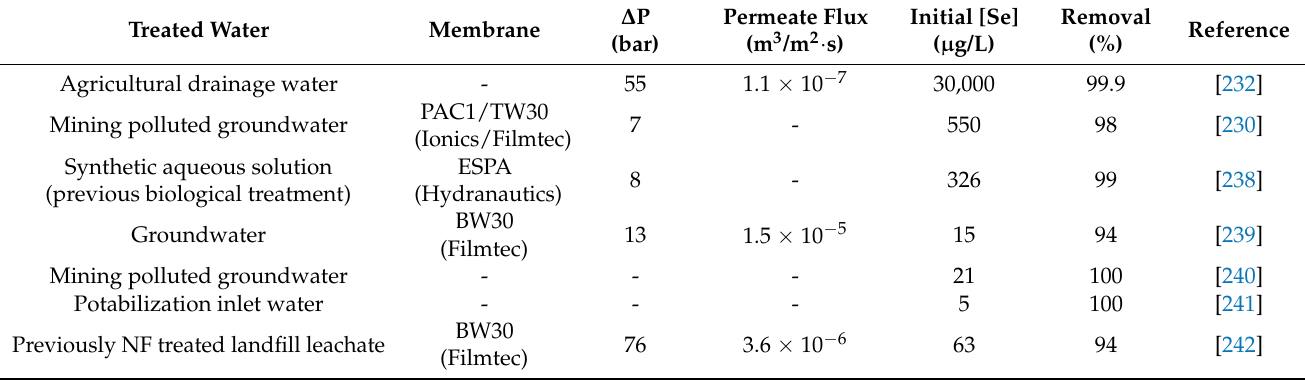
Table 8. Examples of application of reverse osmosis for selenium removal from